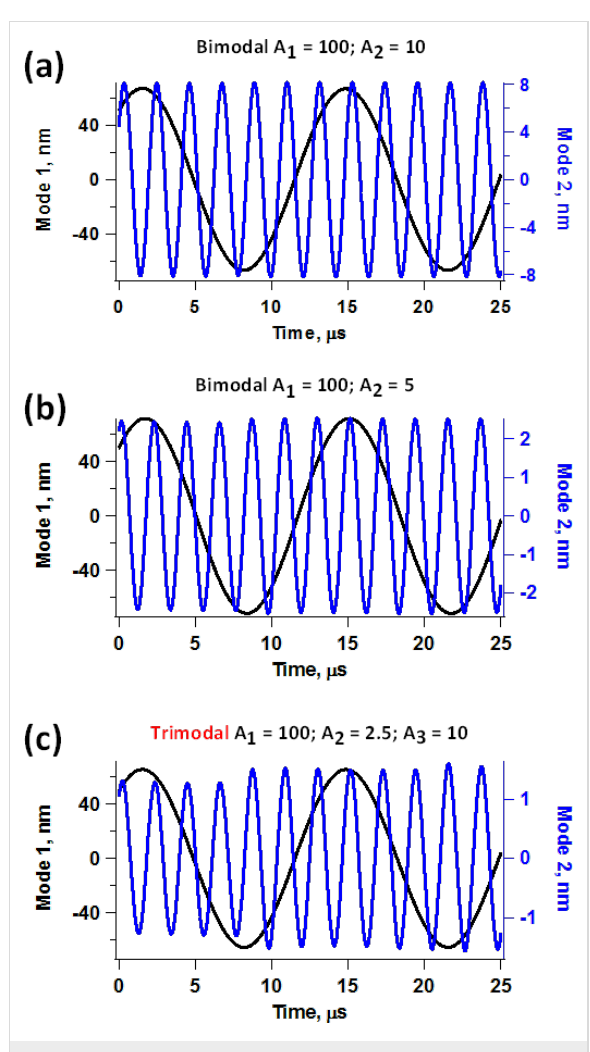
Figure 7: Typical eigenmode responses for bimodal and trimodal AFM operation in air with Q 1 = 150, Q 2 = 450, Q 3 = 750, ν 1 = 70 kHz, ν 2 = 437.5 kHz, ν 3 = 1.25 MHz and k 1 = 2 N/m: (a) bimodal operation with A 1 = 100 nm and A 2 = 10 nm ( A 1 / A 2 = 10); (b) bimodal operation with A 1 = 100 nm and A 2 = 5 nm ( A 1 / A 2 = 20); (c) trimodal operation with A 1 = 100 nm and A 2 = 2.5 nm ( A 1 / A 2 = 40 and A 3 / A 2 = 4). The sample parameters were K o = 10 N/m, K inf = 10 N/m and C d = 1 × 10 − 5